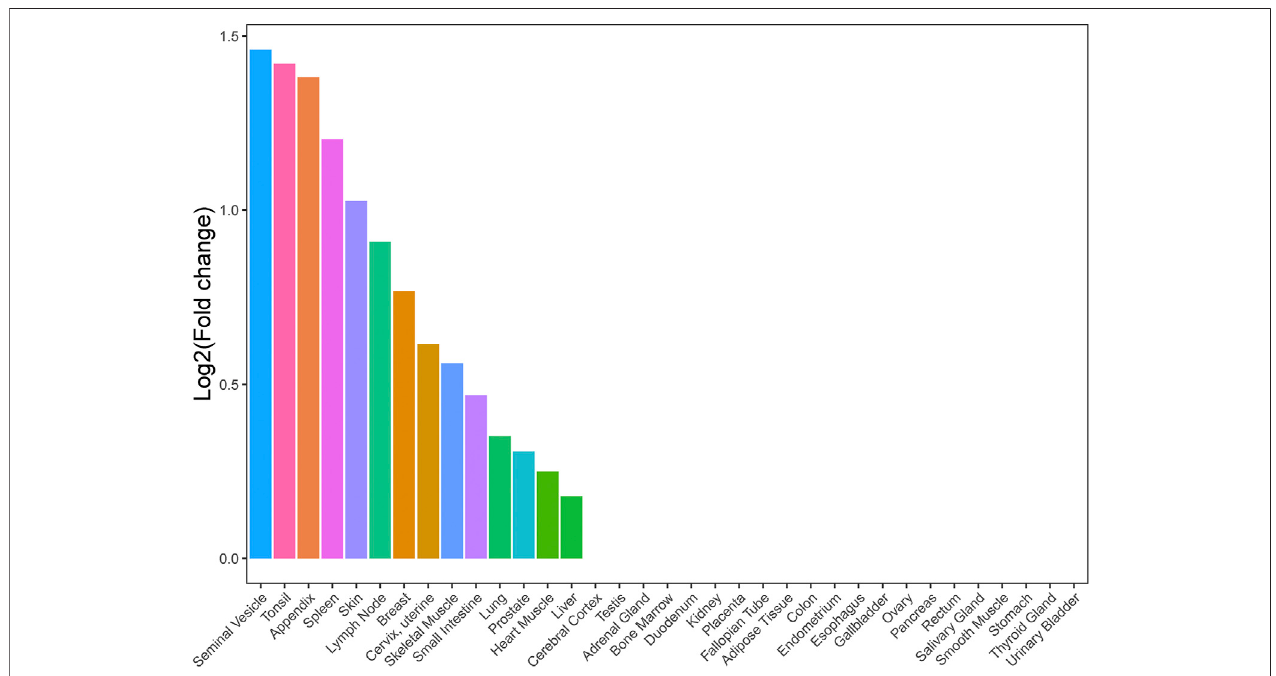
FIGURE 2 | Tissue enrichment analysis result of shared genes between asthma and HF. Vertical axis: the logarithm of tissue expression enrichment fold change based on two; horizontal axis: 35 independent tissues. HF, heart failure.